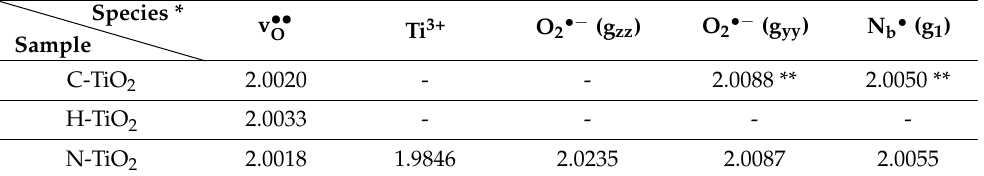
Table 1. Spin Hamiltonian Parameters of the different paramagnetic species in C-TiO 2 , H-TiO 2 , and N-TiO 2 identified by EPR. The uncertainty is about ± 0.0006.